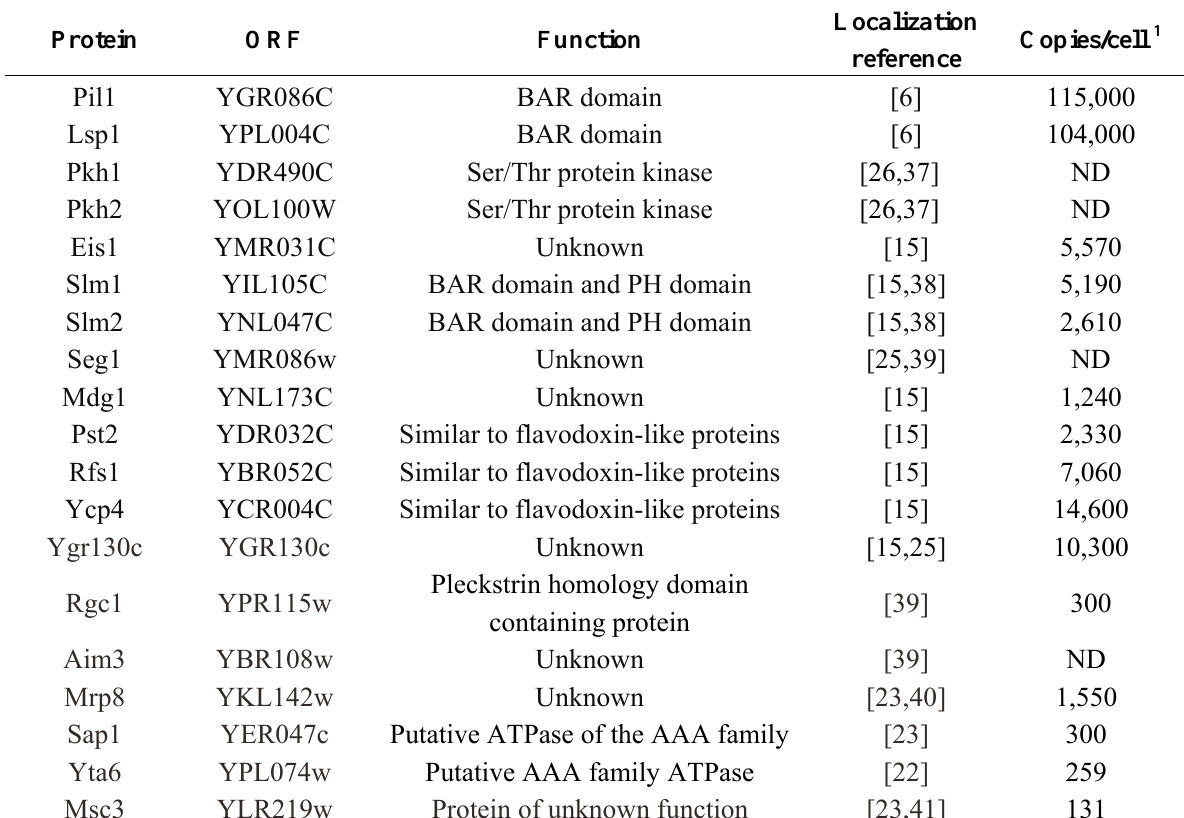
Table 2. S. cerevisiae eisosome